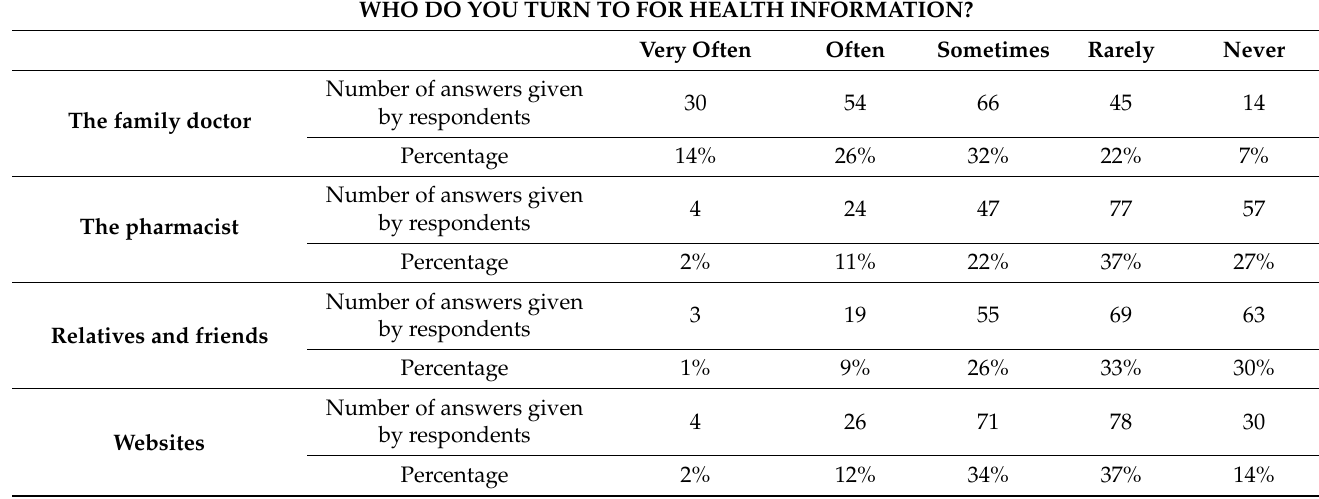
Table 2. Actors/sources used to obtain information related to health problems.